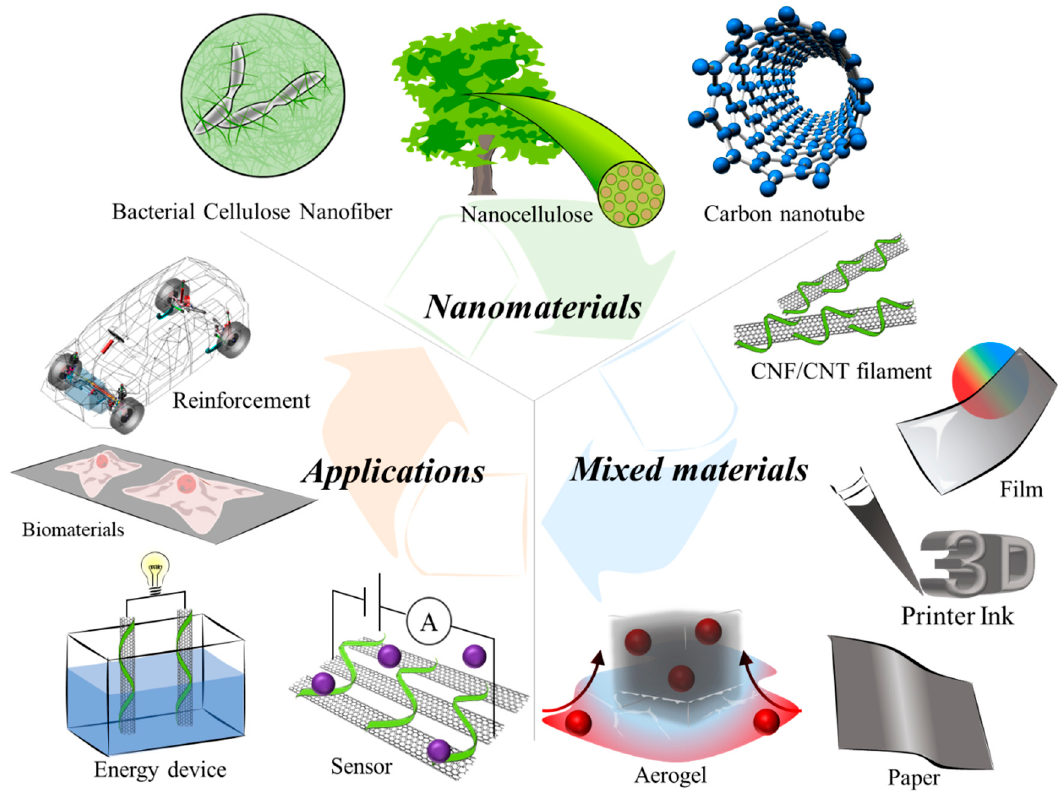
Figure 8. Diagram showing recycling from mixed materials of cellulose, nanocellulose and CNTs to applications. Figure 8 was drawn by author D. Miyashiro and co-author R. Hamano.